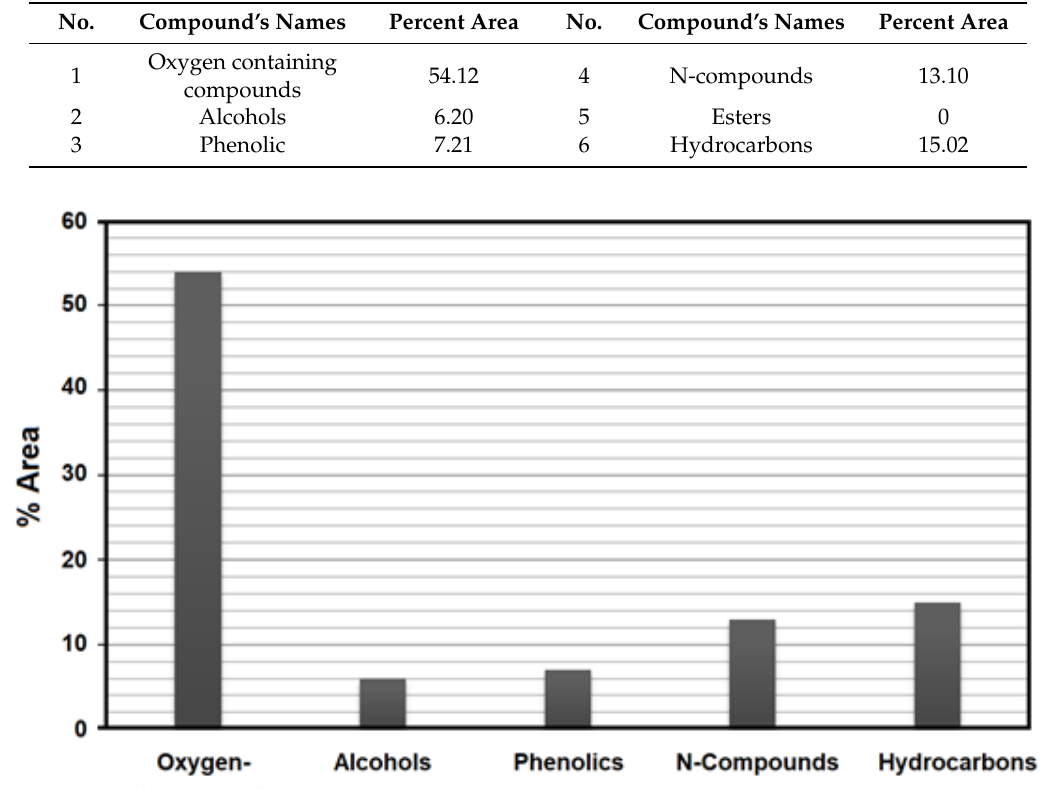
Figure 3. Percent area of all groups identified in SSP. Table 3. Different groups of compounds identified in SSP.